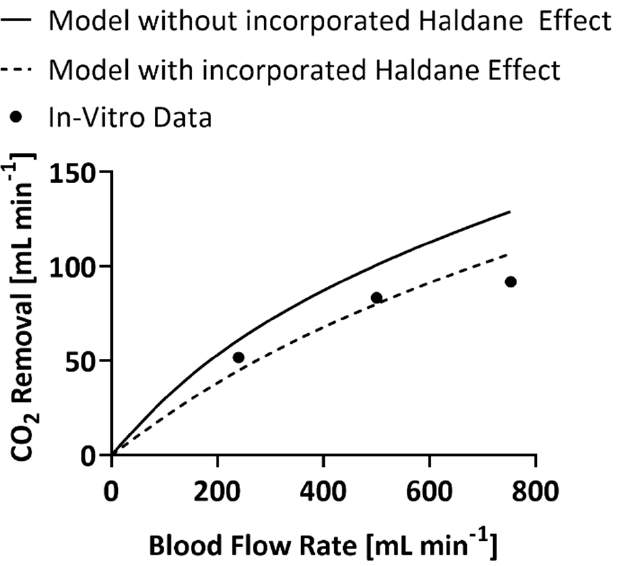
Figure 1. In vitro values of the CO 2 removal rate of the experimental HFM bundle compared to predictions of CO 2 removal by the model that includes the Haldane effect and the one that does not [18]. Error bars are included but are too small to be seen.